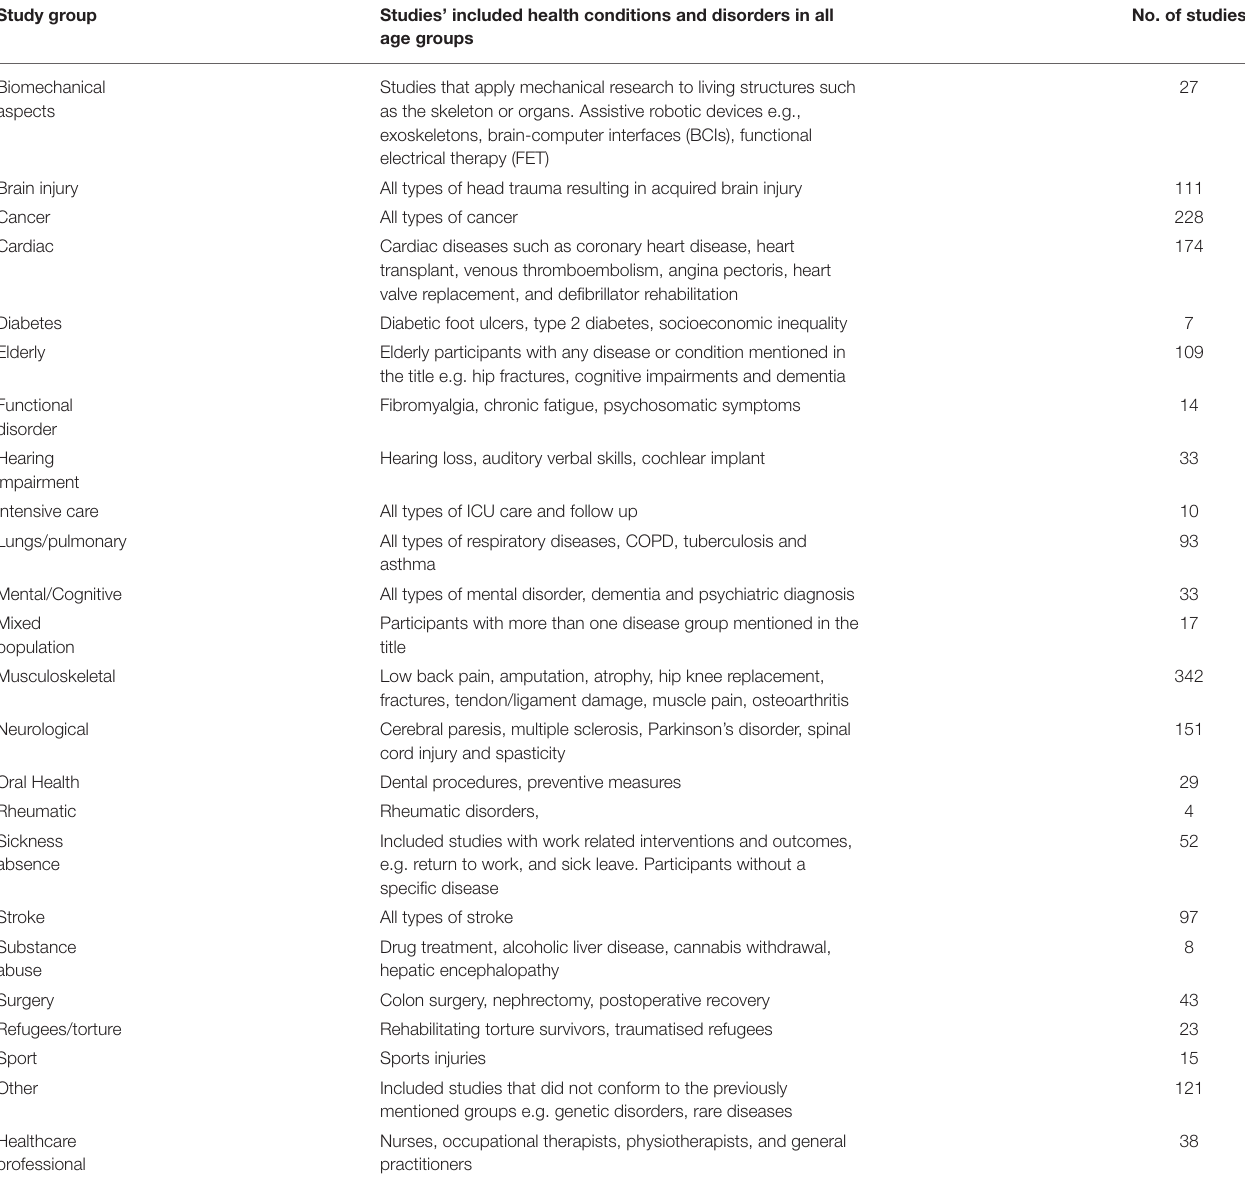
TABLE 2 | Characteristics of study